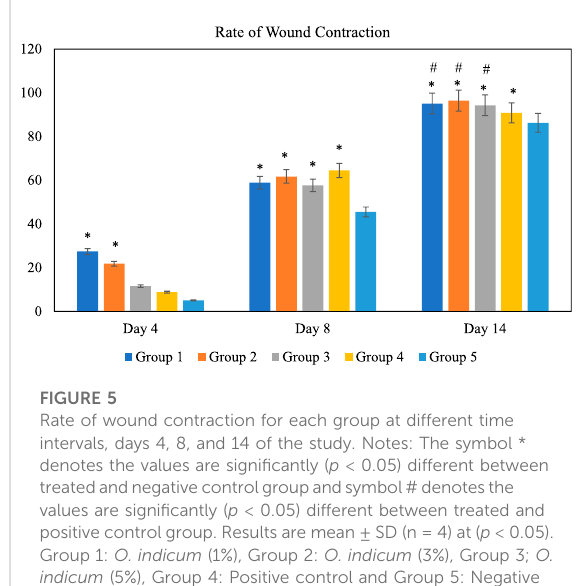
FIGURE 5 Rate of wound contraction for each group at different time intervals, days 4, 8, and 14 of the study. Notes: The symbol * denotes the values are signi fi cantly ( p < 0.05) different between treatedandnegativecontrolgroupandsymbol#denotesthe values are signi fi cantly ( p < 0.05) different between treated and positive control group. Results are mean ± SD (n = 4) at ( p < 0.05). Group 1: O. indicum (1%), Group 2: O. indicum (3%), Group 3; O. indicum (5%), Group 4: Positive control and Group 5: Negative